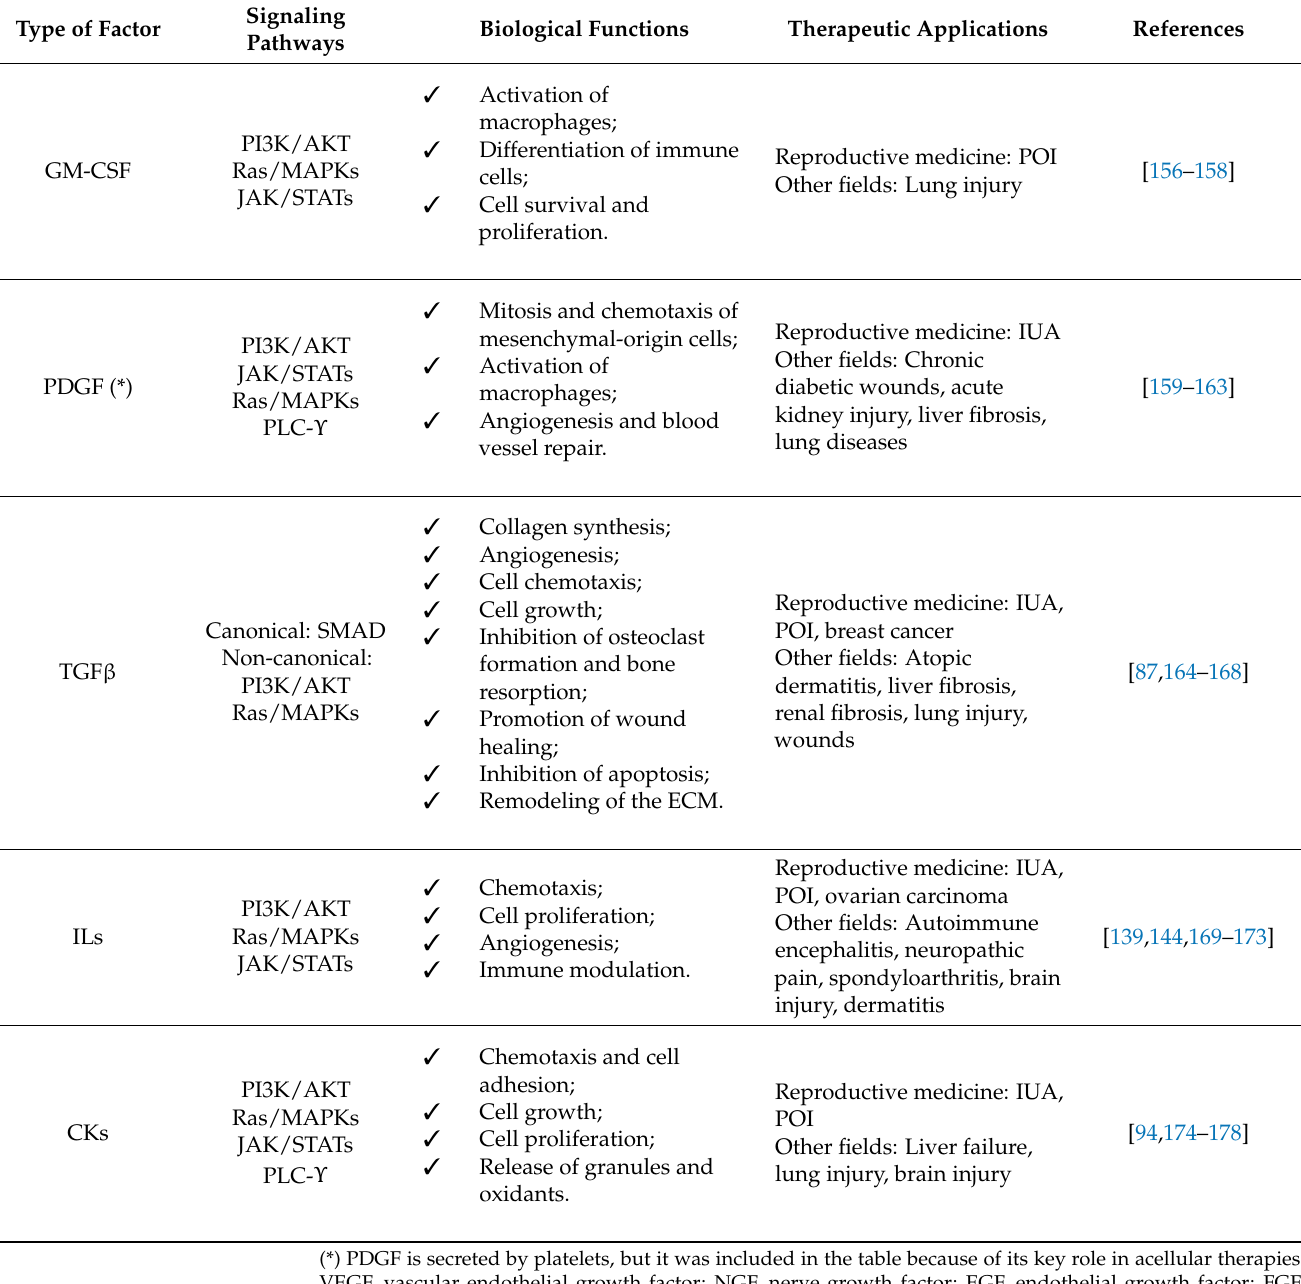
Table 1. Cont. Table 1. Main growth factors secreted by hUC-MSCs and found in the acellular components of hUC blood. For each growth factor, this table lists the most prominent signaling pathways, biological functions, and therapeutic applications reported in the literature in reproductive medicine and other medical fields.